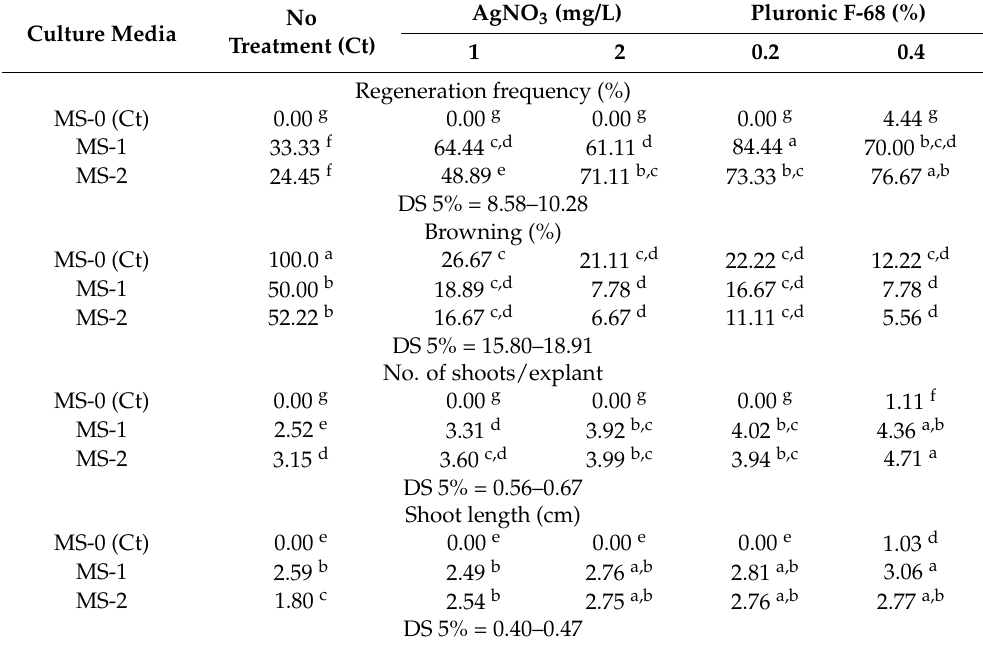
Table 6. Phenolic inhibitors and culture medium influence on axillary shooting in P. quadrangularis